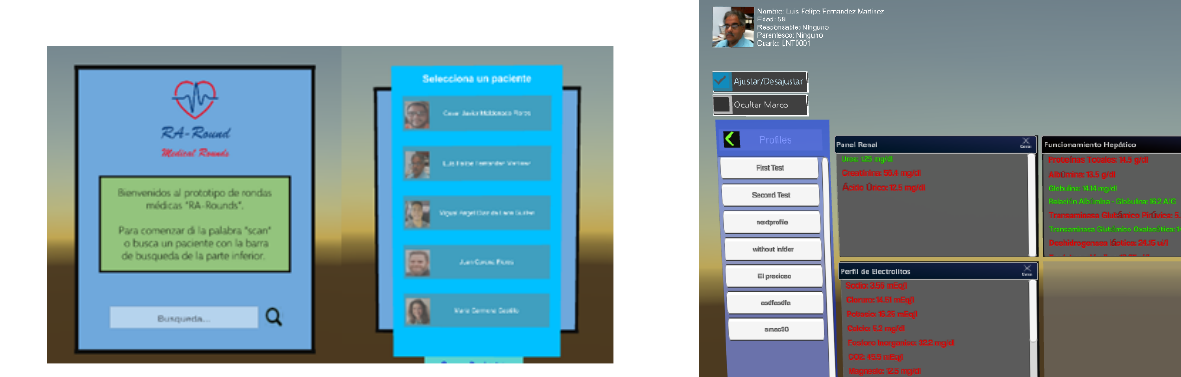
Figure 5. Authentication gameObject.